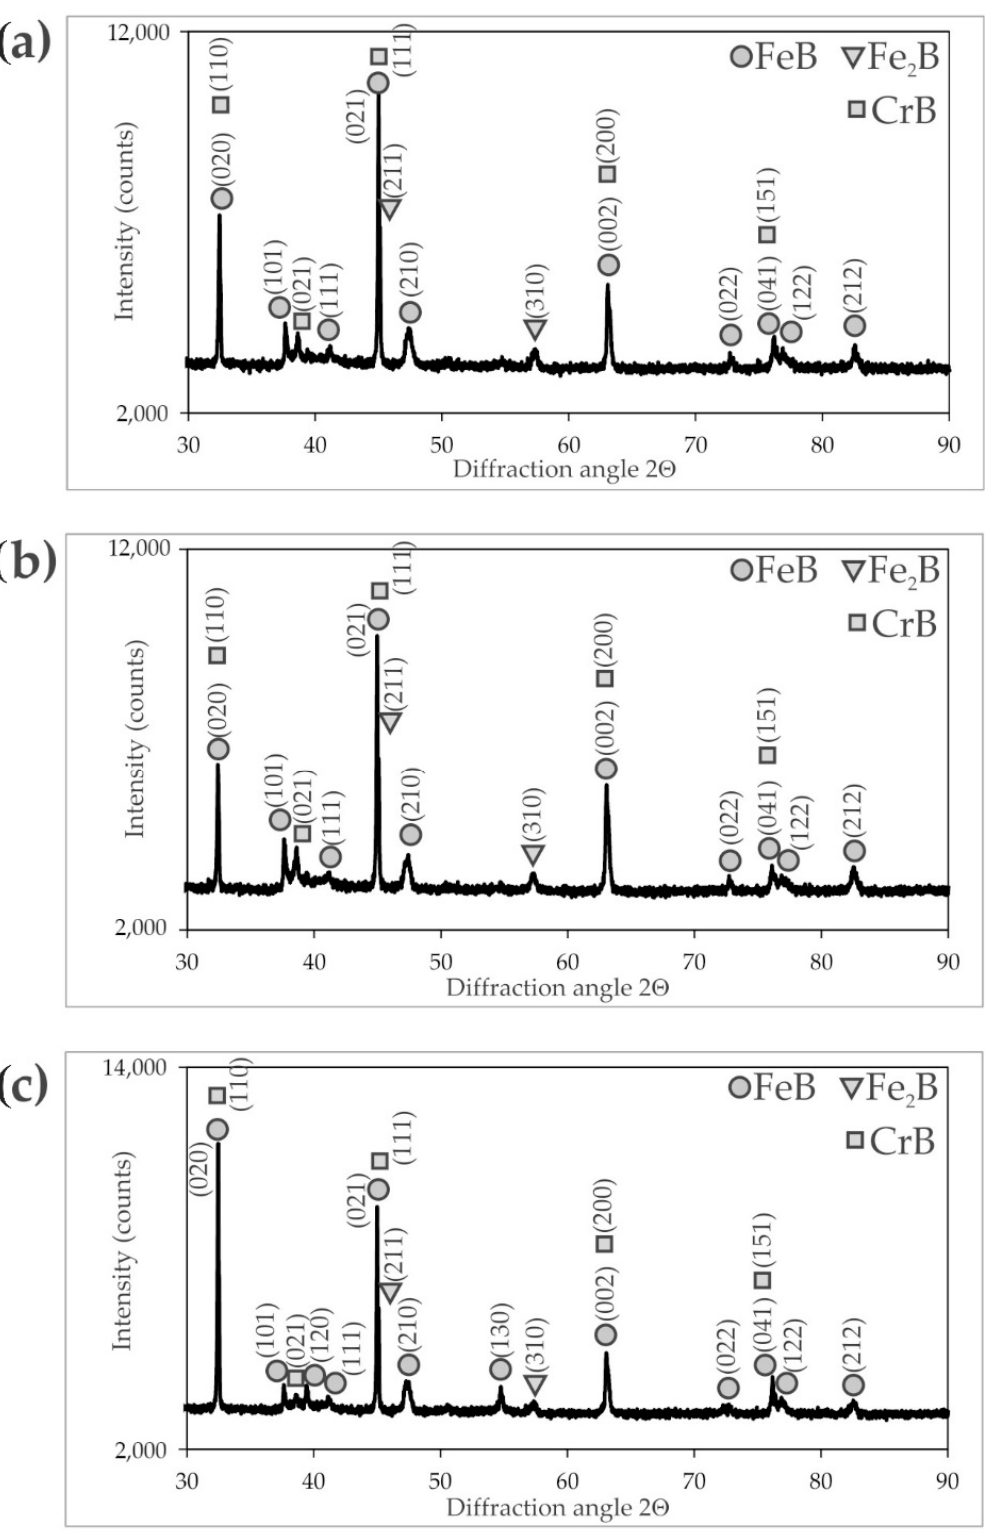
Figure 4. XRD patterns of X165CrV12 steel after powder-pack boriding at 1173 K: ( a ) for 3 h, ( b ) for 6 h, ( c ) for 9 h.